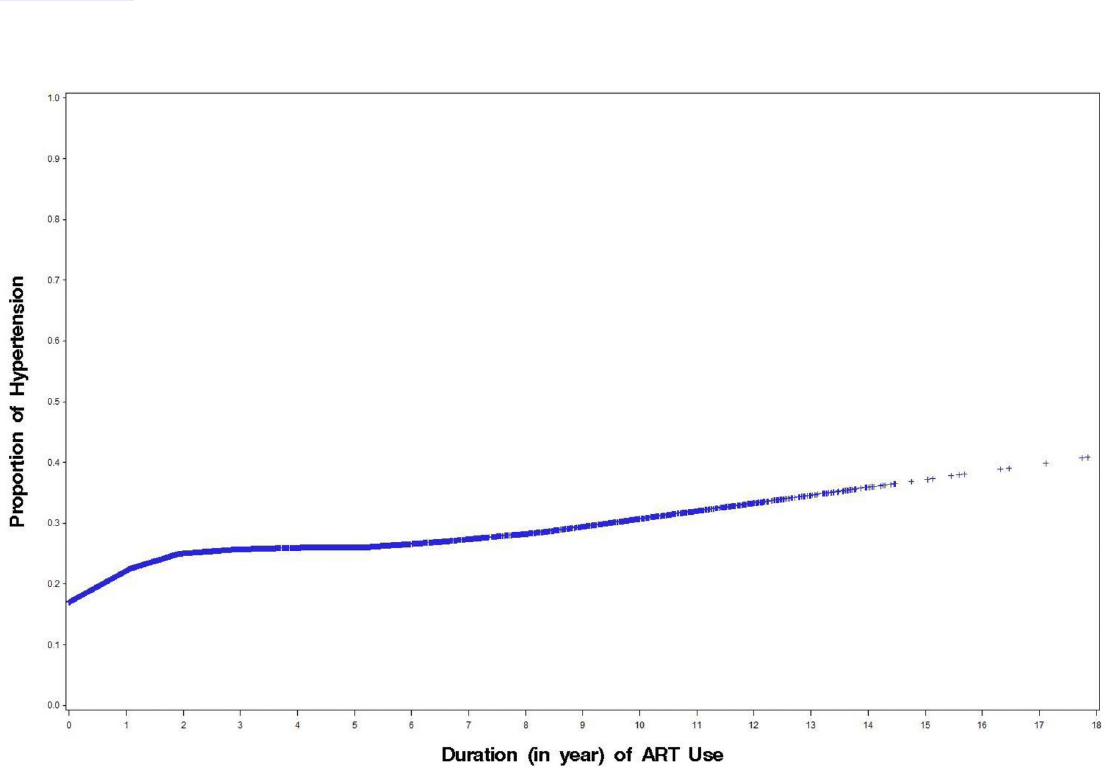
Fig 3. Loess for prevalent hypertension and duration of antiretroviral therapy (ART)